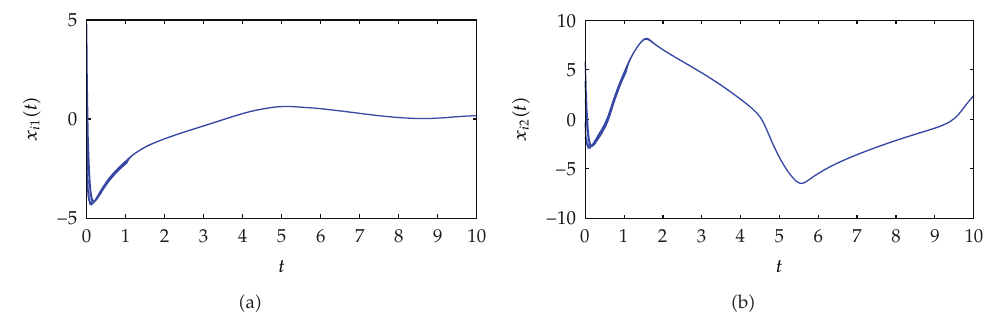
Figure 1: The trajectories of the state variables of x i 1 and x i 2 (cid:3) i (cid:8) 1 , 2 ,..., 5 (cid:4) in system (cid:3) 4.3 (cid:4) under pinning control.